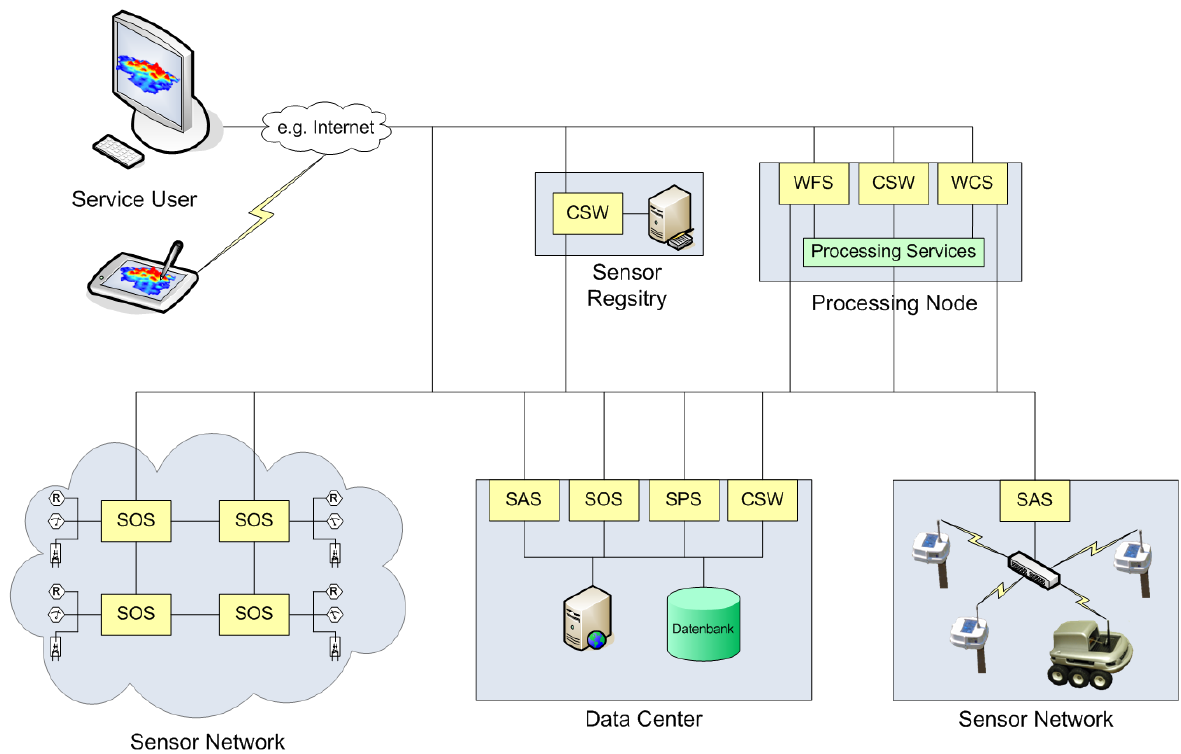
Figure 6. Functional connections between the SWE